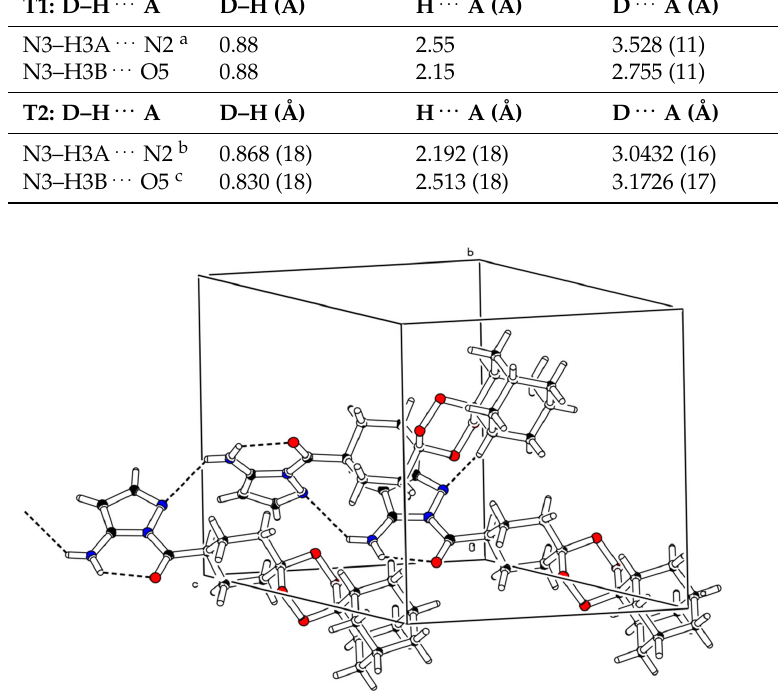
Table 3 : Hydrogen bonding information for the crystalline structures of isomers T1 and T2. Symmetry codes: a: x,y, − 1+ z; b: 1 − x, 2 − y ,1 − z; c: 1 − x, 1/2 +y, 1/2 − z.